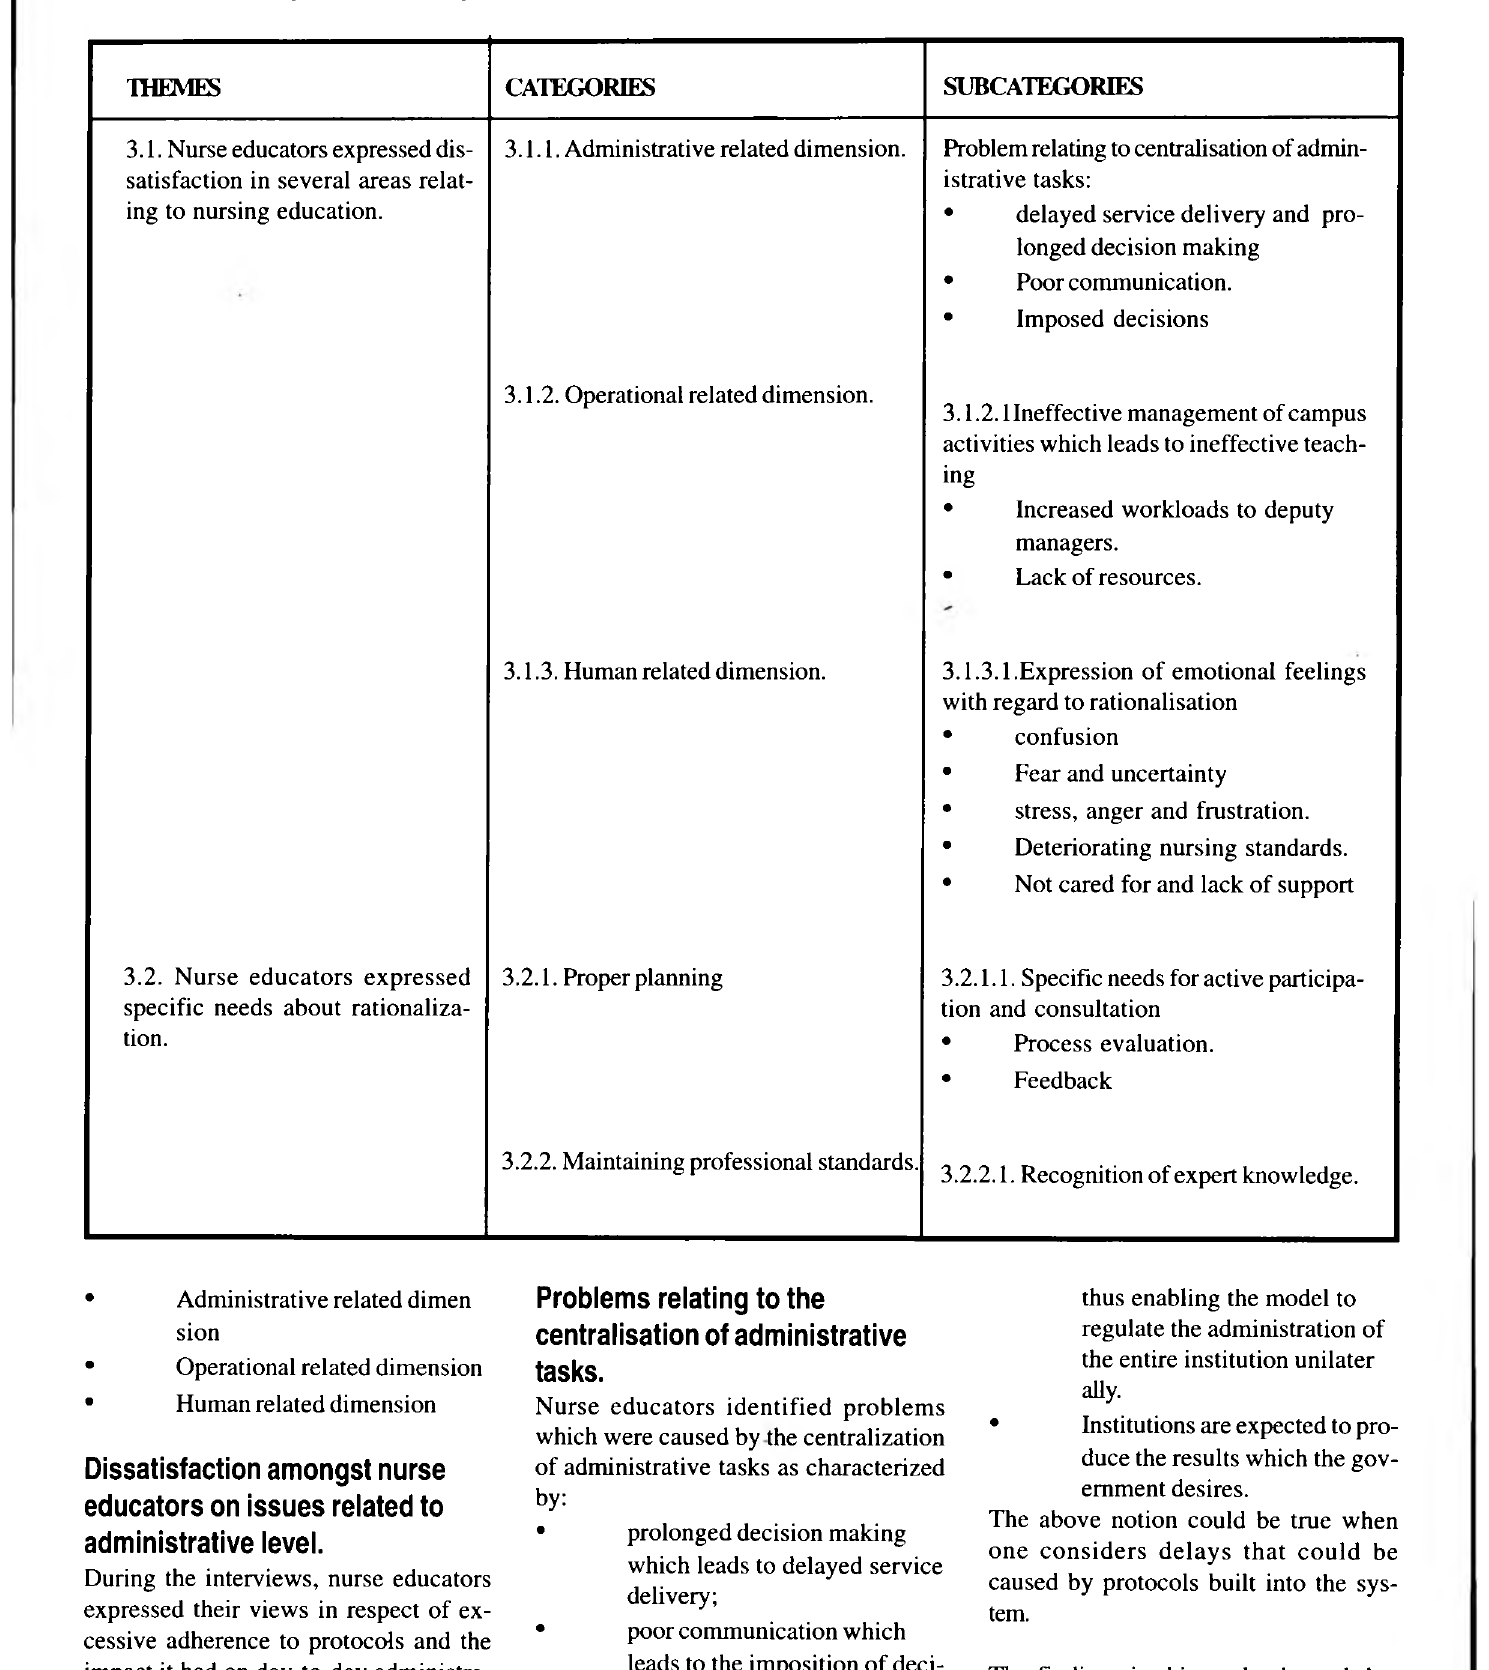
Table 1: Summary of the findings.